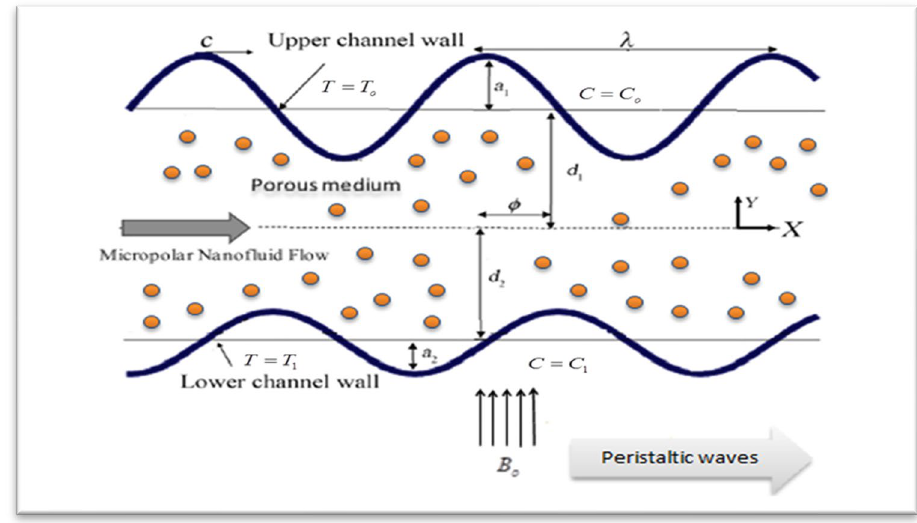
Figure 1. Geometrical illumination of the physical